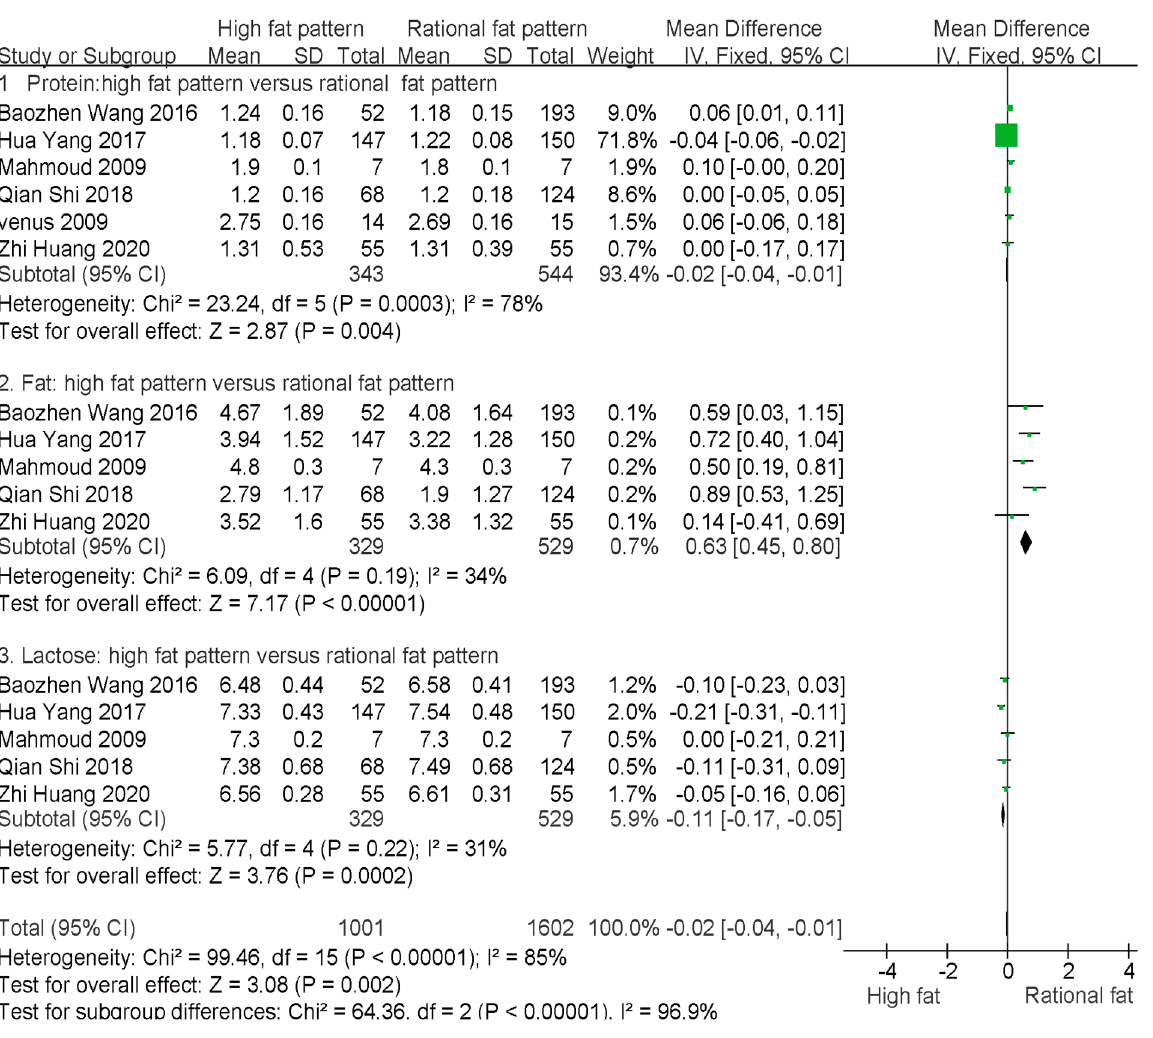
Figure 5. Forest map shows the comparison of breast milk macronutrient contents between high-fat dietary pattern and rational-fat dietary pattern [31,34,40,41,44,56]